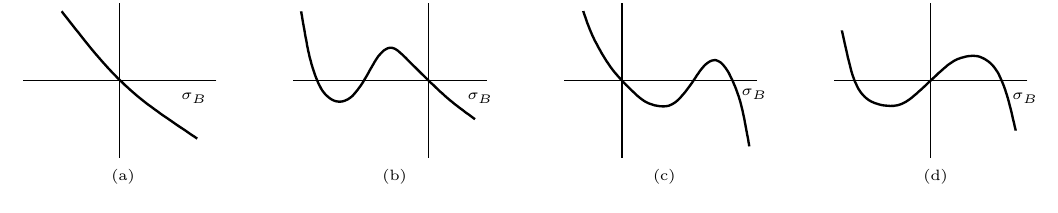
Figure 10 . E(cid:11)ective potential for x 6 < (cid:30) 1